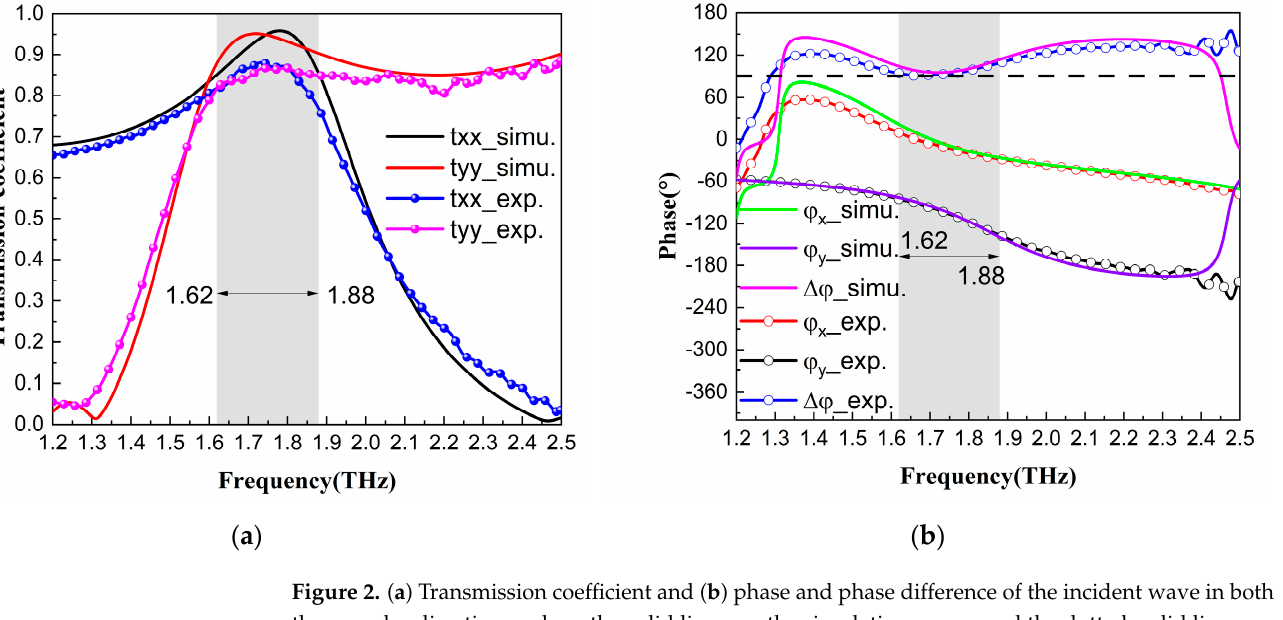
Figure 2. ( a ) Transmission coefficient and ( b ) phase and phase difference of the incident wave in both the x- and y-directions, where the solid lines are the simulation curves and the dotted, solid lines are the experimental curves.